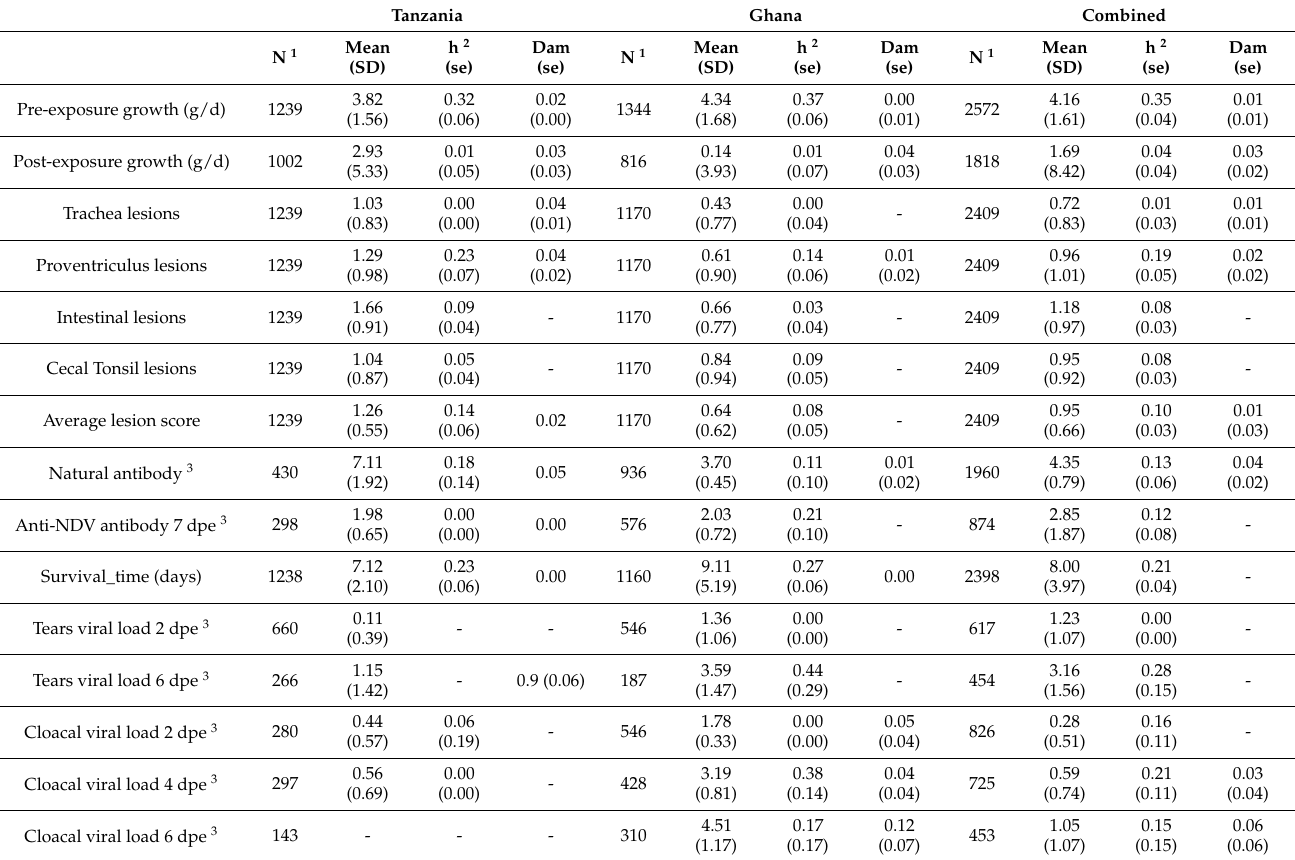
Table 2. Phenotypic descriptive statistics and estimates of variance components (proportions of phenotypic